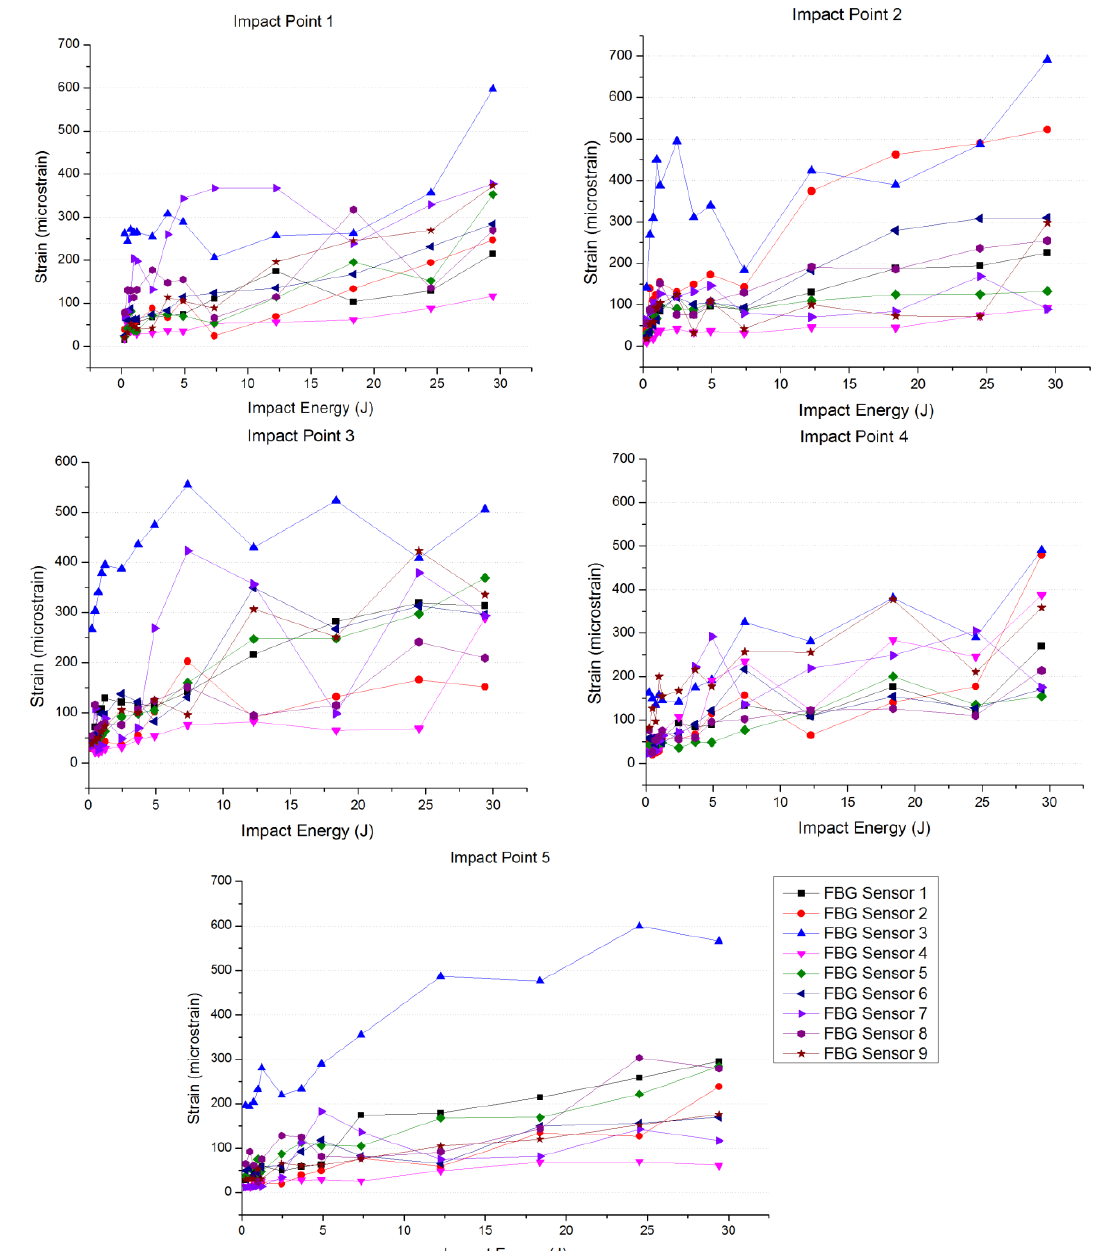
Figure 8. Relation between the impact energy and the strain